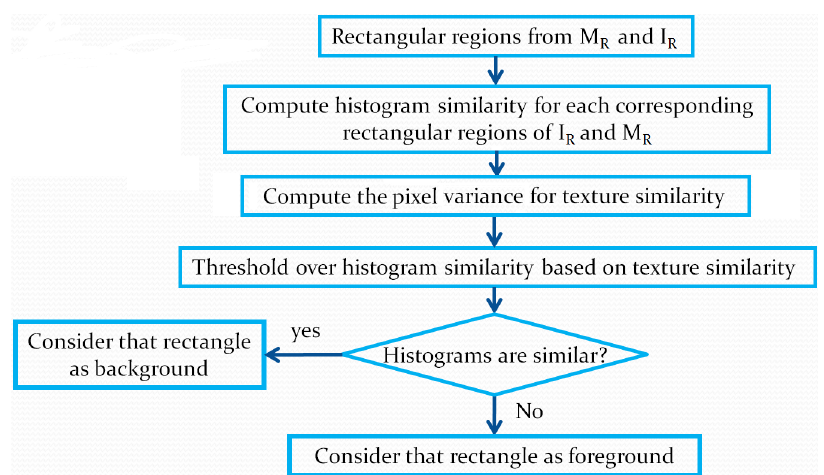
Figure 4. Motion detection criterion.